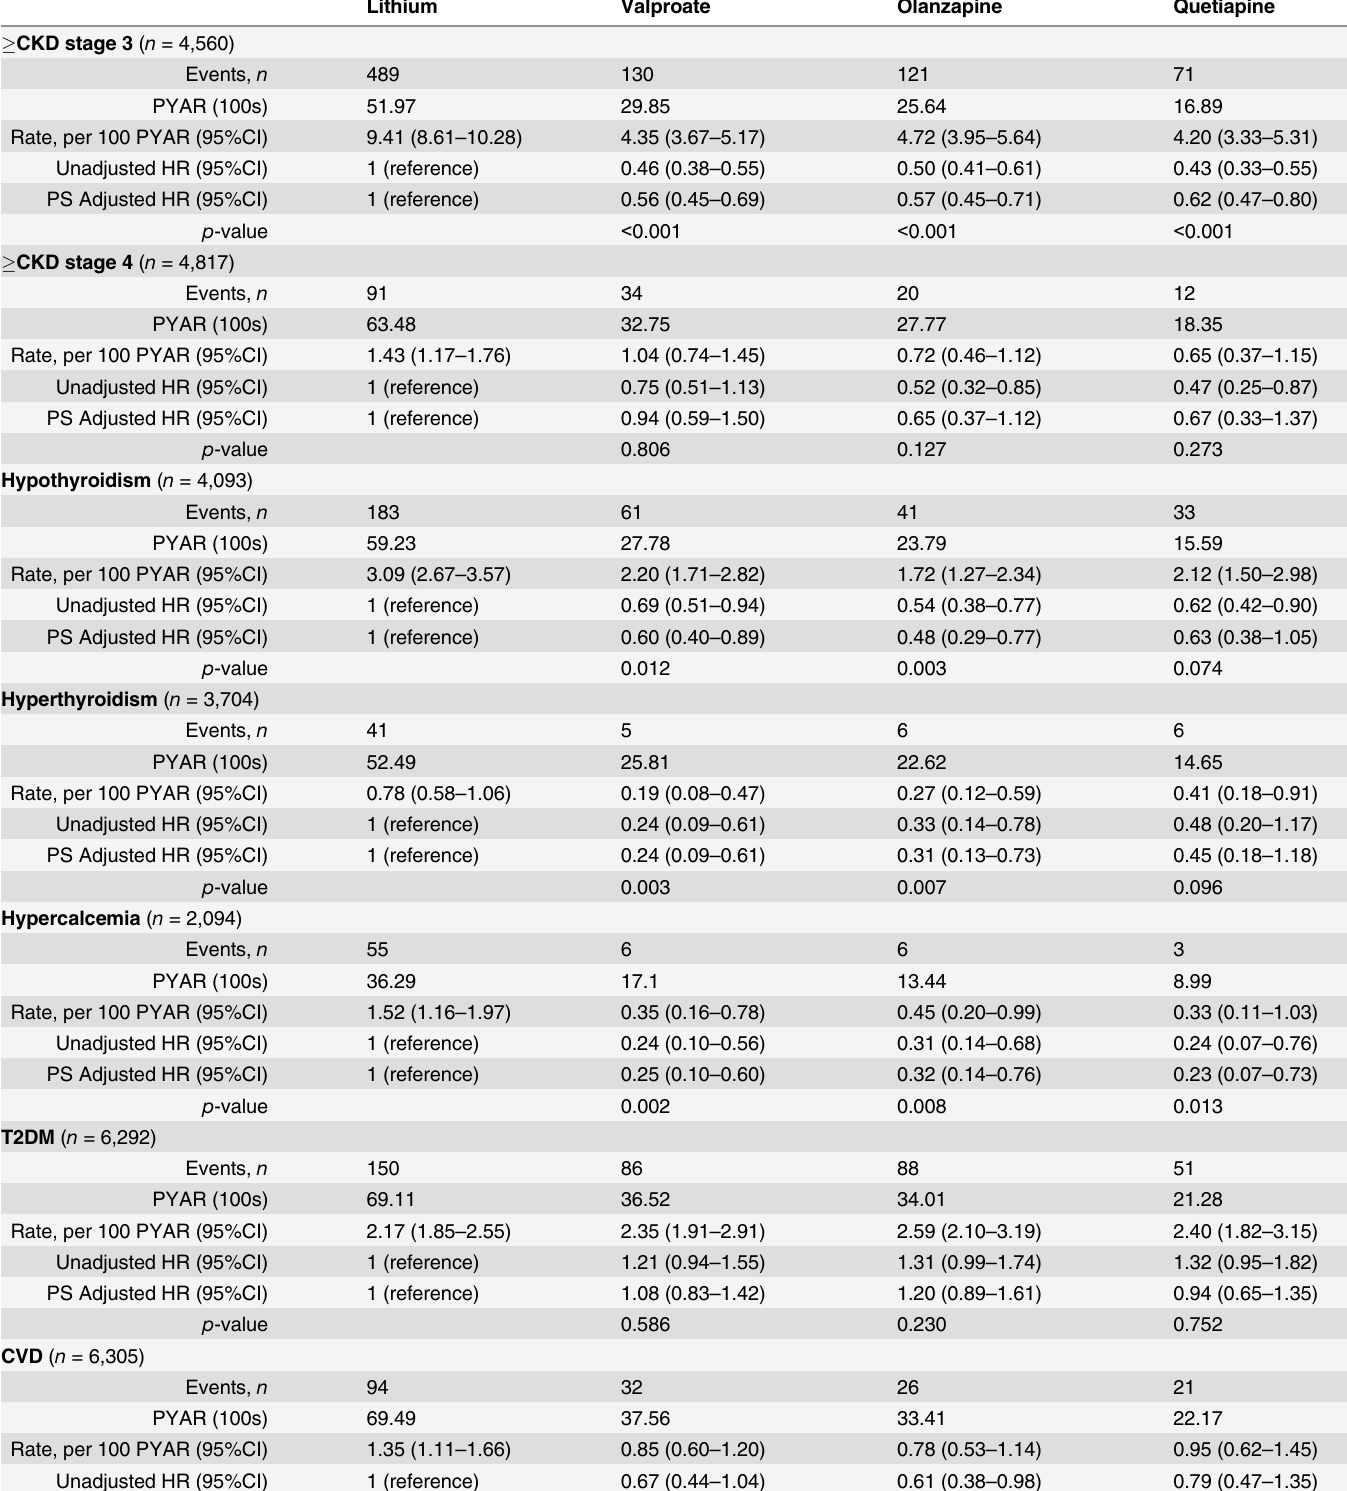
Table 2. Adverse effects during maintenance treatment. Lithium Valproate Olanzapine